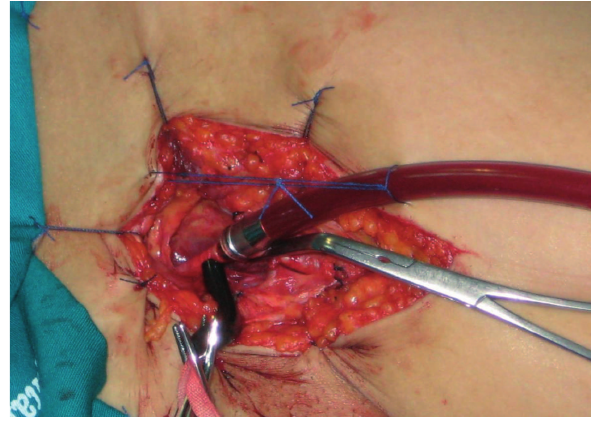
Fig. 2 - Canulação da artéria femoral esquerda.